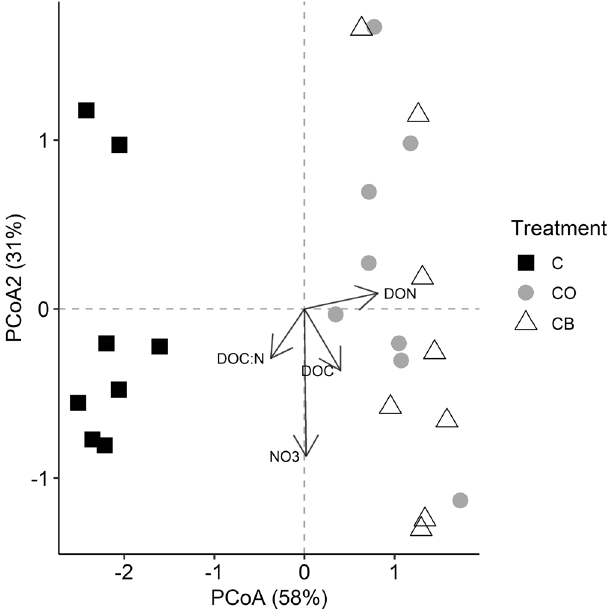
Figure 1. Principal coordinates axes of soil abiotic characteristics (pH, moisture, labile C, DOC, DON, DOC:N Ratio, inorganic N, total C:N Ratio) using Euclidean dissimilarities between samples. There was strong separation in soil abiotic characteristics in carrion addition plots relative to the control. Squares indicate controls (C), circles indicate carcass only (CO), and triangles indicate burying beetle plots (CB). Soil abiotic characteristics with a covariance greater than 0.3 were retained (indicated by